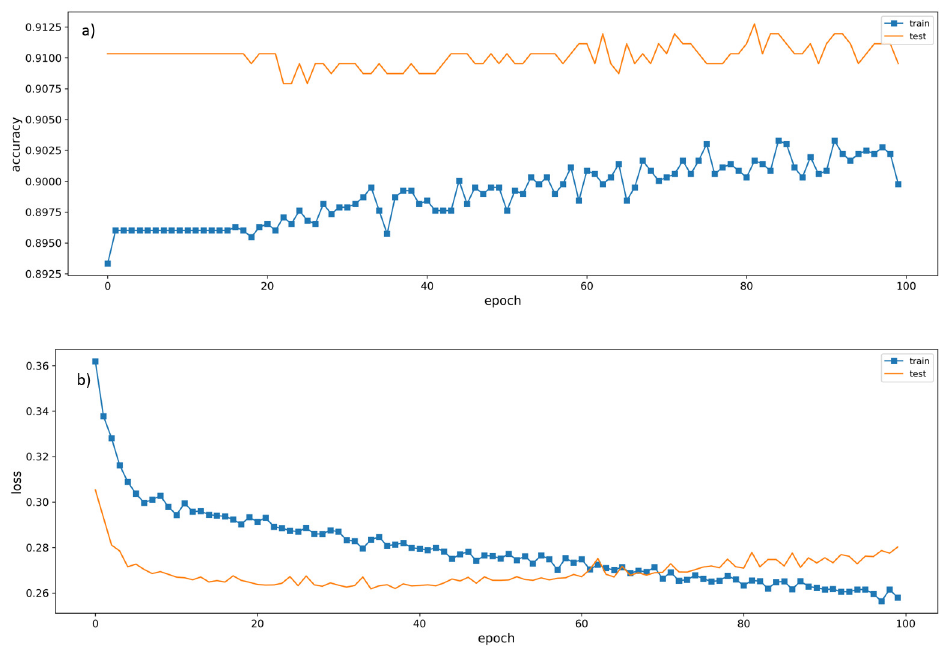
Figure 13. CNN training plots of ( a ) accuracy and ( b )